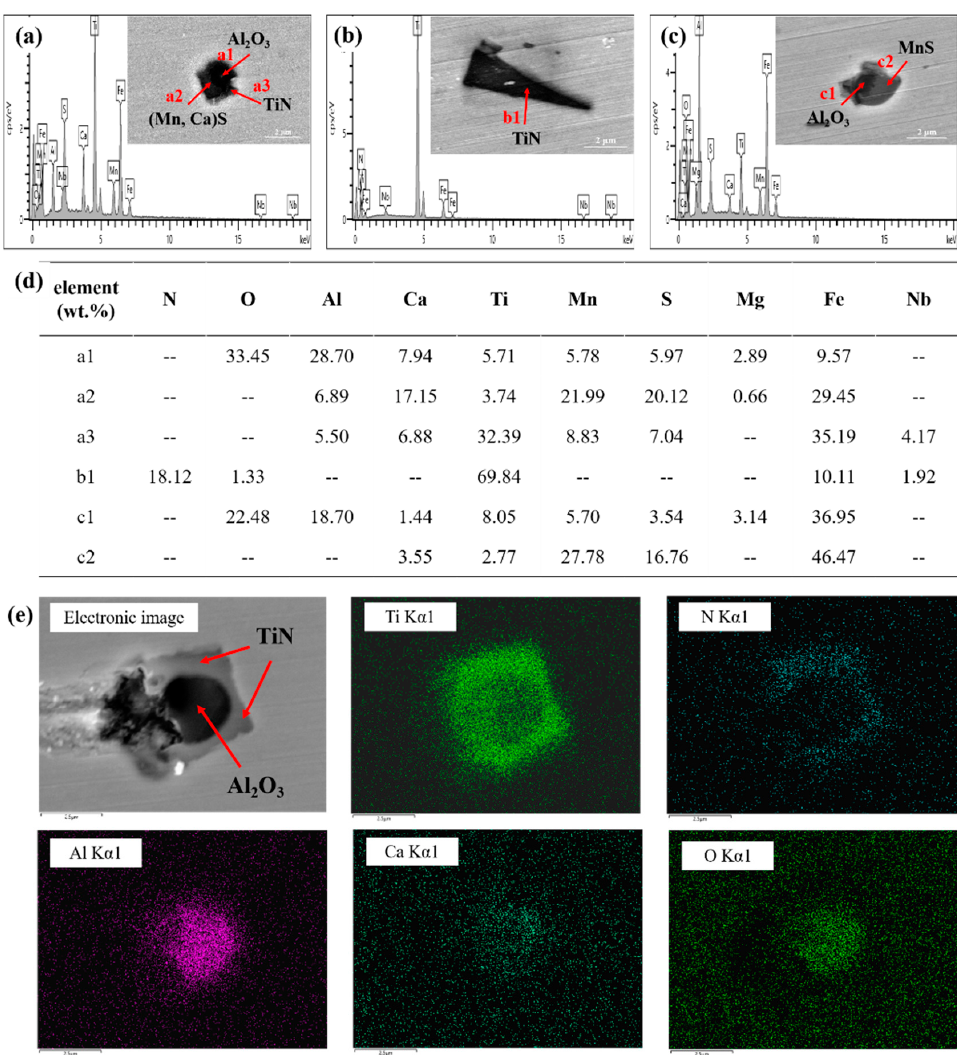
Figure 4. Morphological characteristics of inclusions in Beam-1 steel. ( a – c ) typical inclusion mor- phology; ( d ) chemical composition of the corresponding inclusions; ( e ) detailed characteristics of the typical core-shell inclusion.